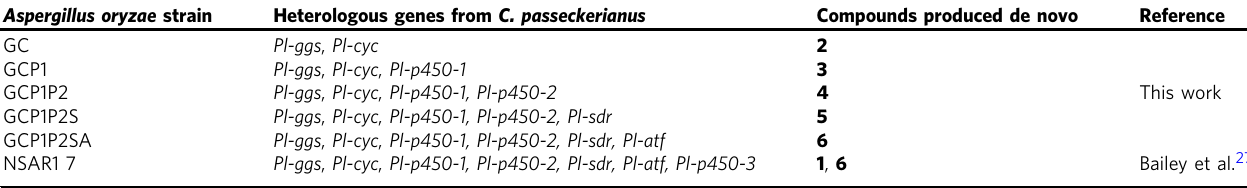
Table 1 List of Aspergillus oryzae strains generated Aspergillus oryzae